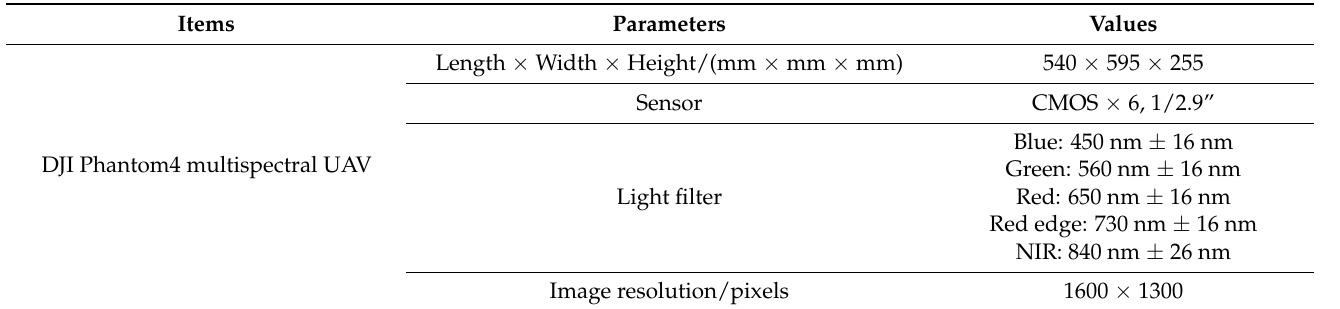
Table 1. Key parameters of DJI multispectral UAV.